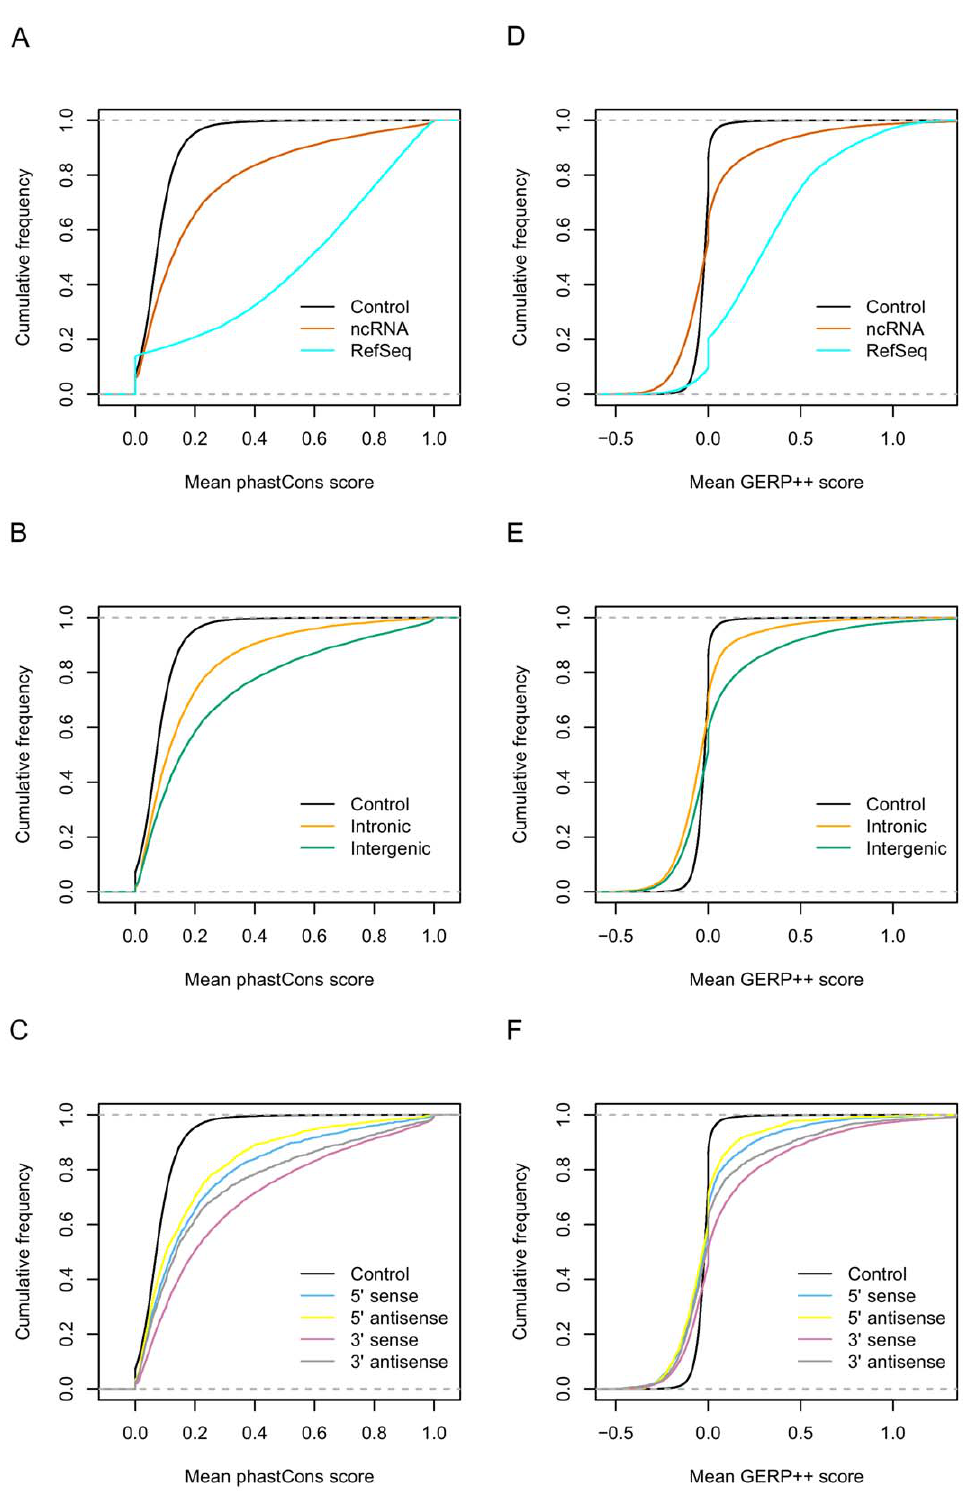
Figure 7. Sequence conservation analysis of ncRNAs. (A, B & C) are based on phastCons score. (D, E & F) are based on GERP ++ score. The control line is based on a similar number of randomly selected non-transcribed genomic regions. A & D – ncRNAs compared to RefSeqs, B & E – intergenic ncRNAs compared to intronic and C& F – 5 9 vs 3 9 ncRNAs and transcriptional orientation with respect to nearest neighbour genes.